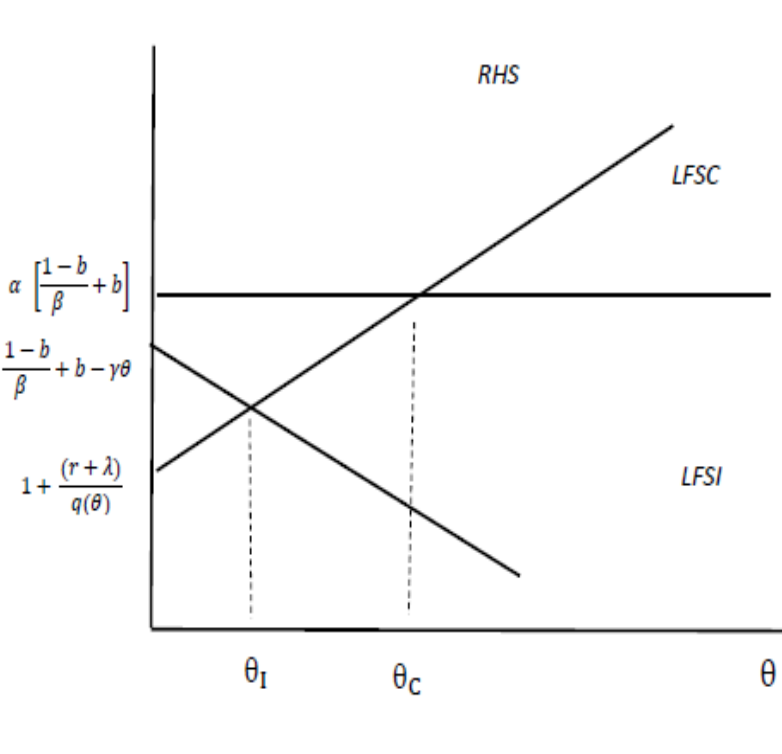
Figure 4: Demonstration of proposition